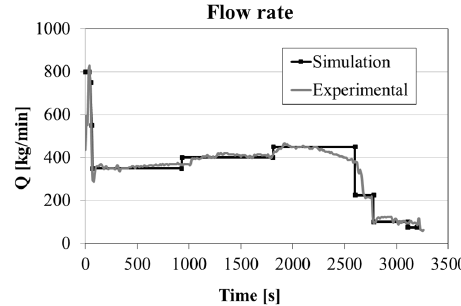
Figure 4. Teeming flow rate vs. time recorded during experiment and simulated.